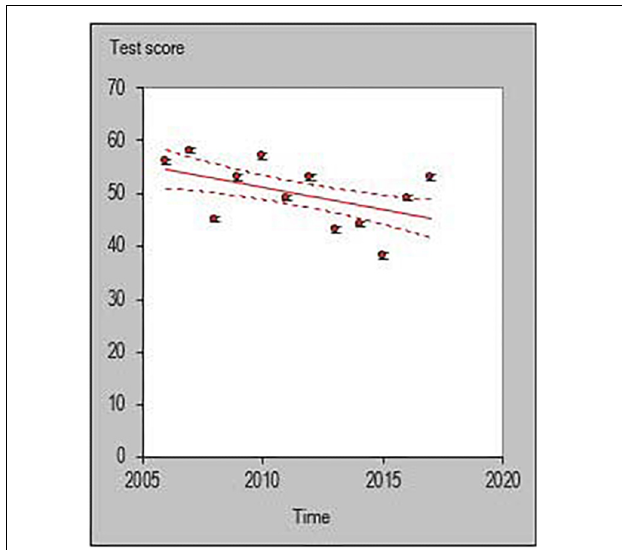
FIGURE 5 | Individual trend of one participant for 2-point percentage per season.